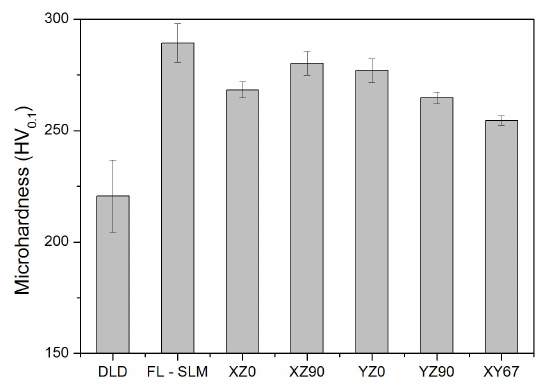
Figure 11. Microhardness (HV 0.1 ) of the AM samples.